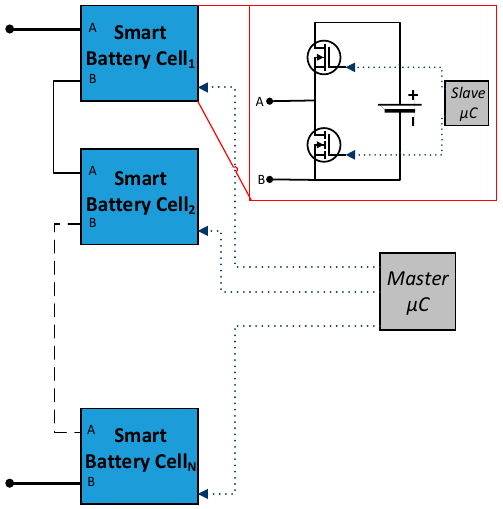
Figure 2. Block diagram of the smart battery pack.